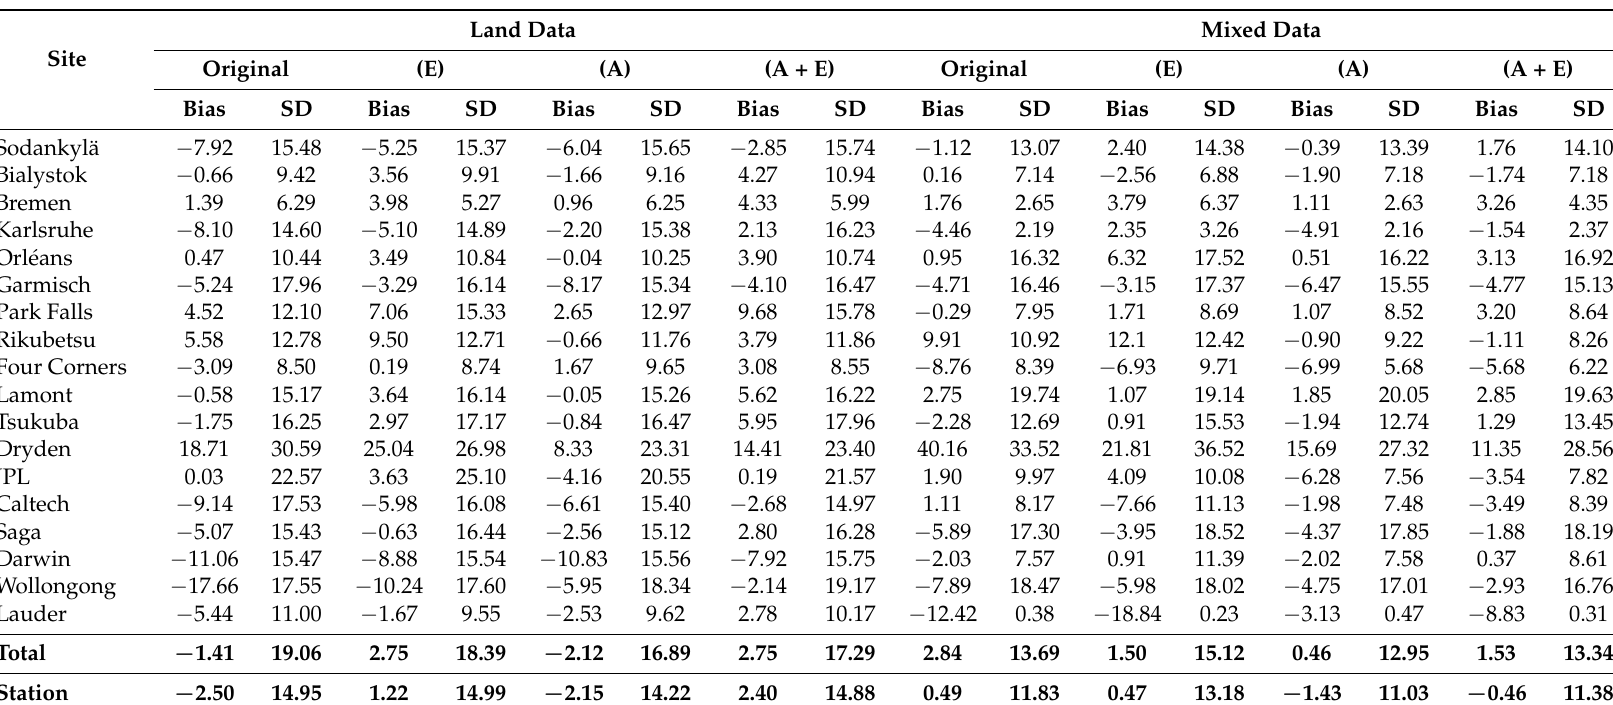
Table 6. Comparison of biases and standard deviations (SD) among the three bias correction methods at the 18 TCCON sites for case 1. (E) Empirically derived bias correction, (A) altitude bias correction, and (A + E) altitude bias correction followed by empirically derived bias